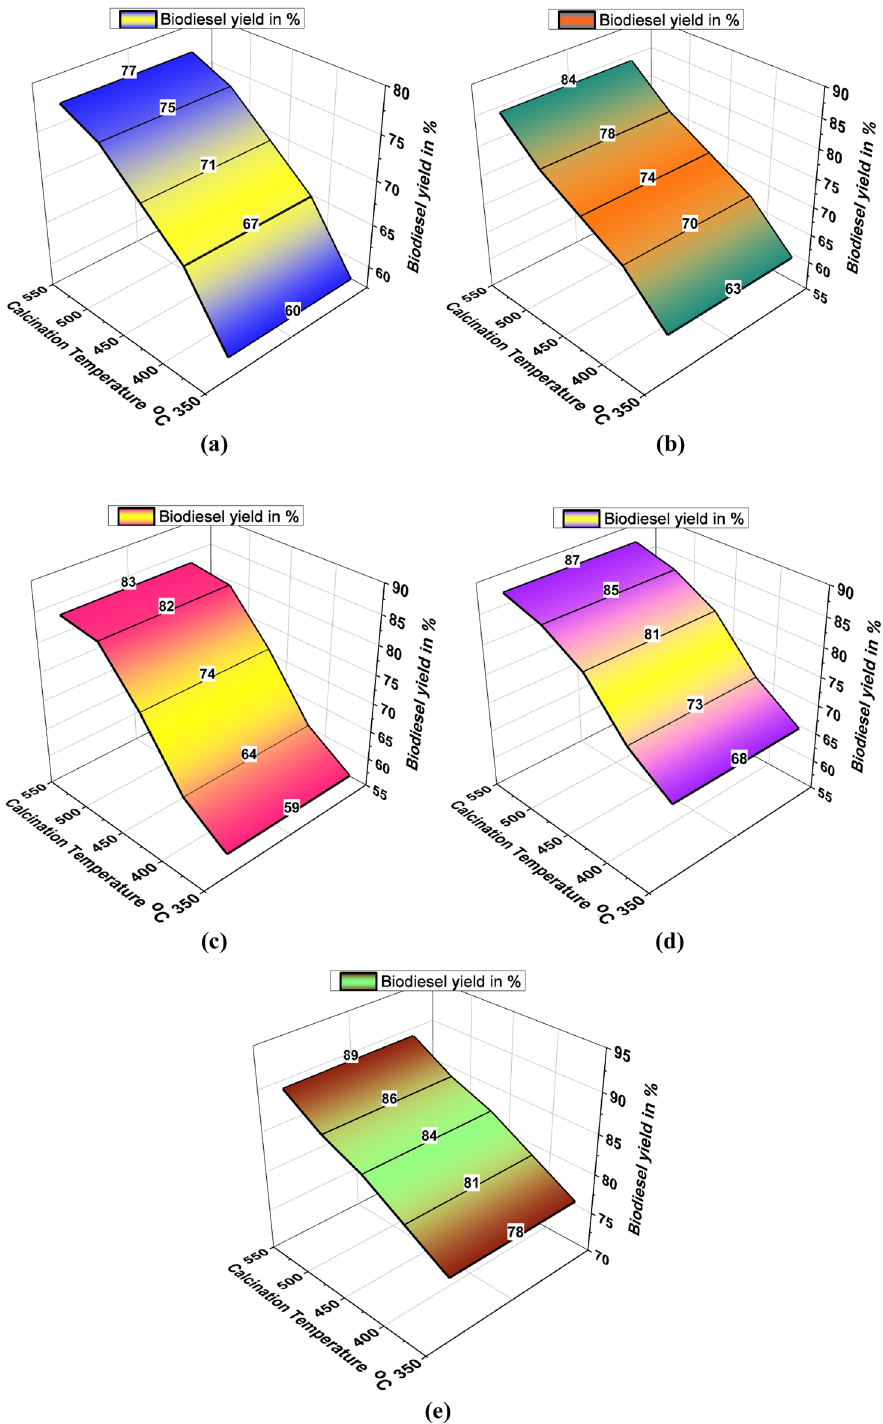
Figure 2. Calcination temperature vs. biodiesel yield in % using of plant waste: ( a ) Bagasse ( b ) Papaya stem ( c ) Banana peduncle ( d ) Moringa oleifera ( e ) Mixed